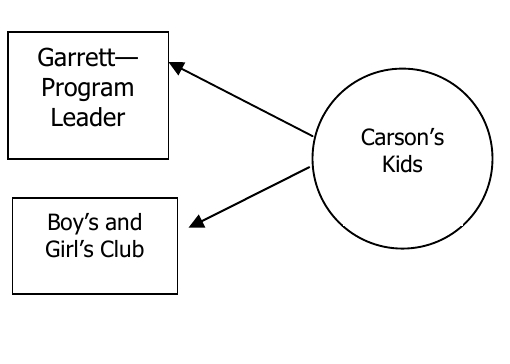
End of Year 1 Carson’s Kids Example